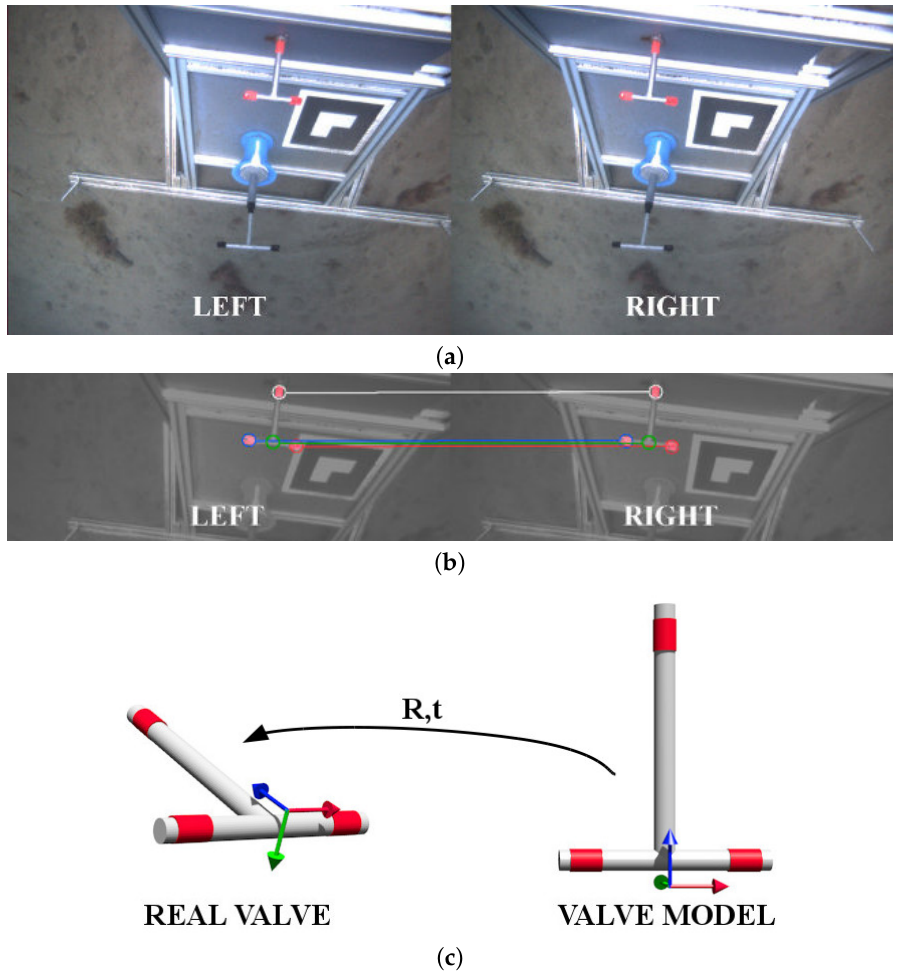
Figure 4. Valve detection procedure: ( a ) original stereo pair; ( b ) blob detection and matching; and ( c ) rigid transformation